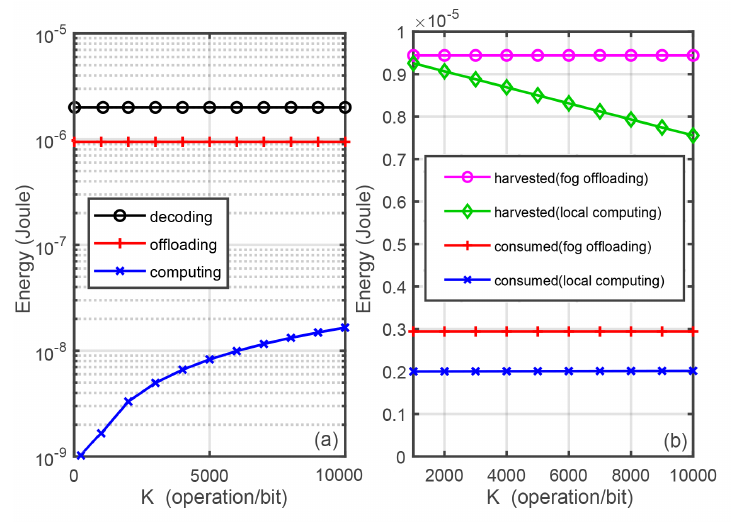
Figure 3. Harvested and required energy per frame versus K